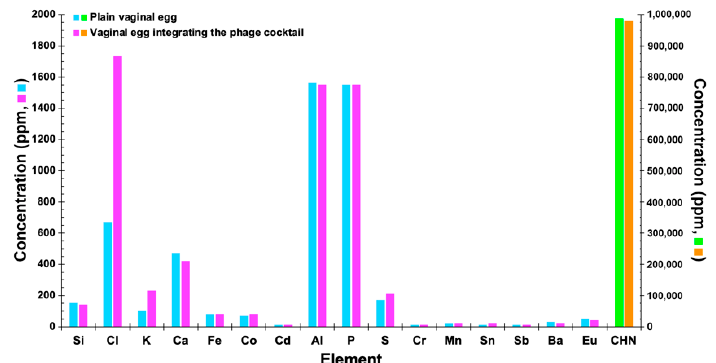
Figure 13. Elemental profile of the plain vaginal egg and of the vaginal egg formulation integrating the phage cocktail, obtained by EDXRF.